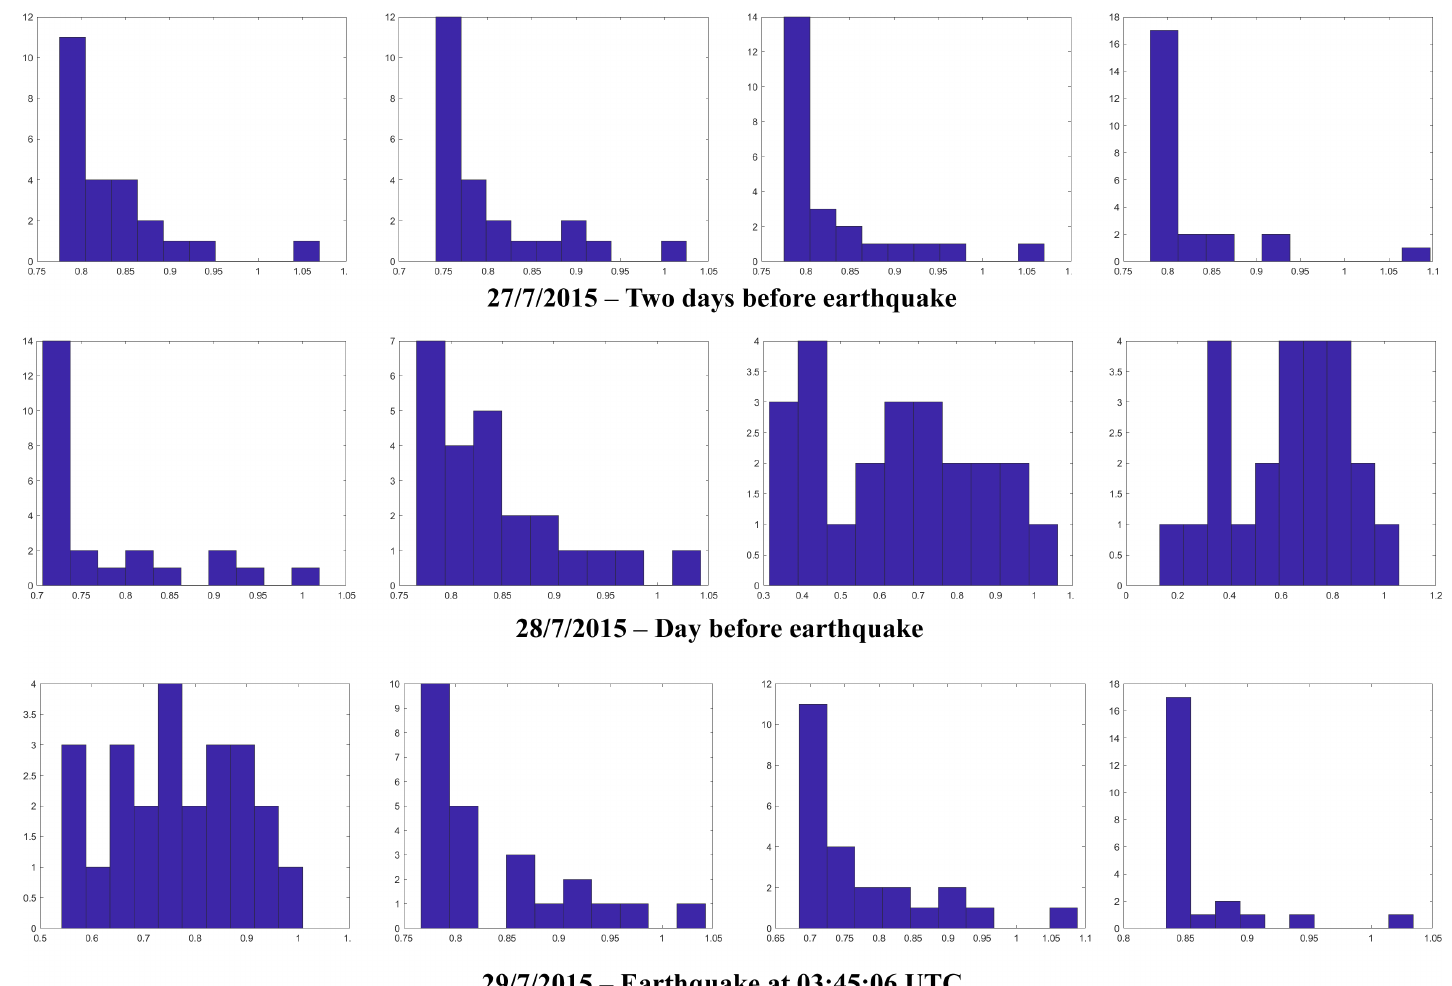
Figure 2. Eigenvalue distribution of the correlation matrix for the VLF amplitude data. Wigner-like behavior can be seen before the earthquake. Four images in the row corresponding to times 00:00 to 06:00, 06:00 to 12:00, 12:00 to 18:00, and 18:00 to 24:00